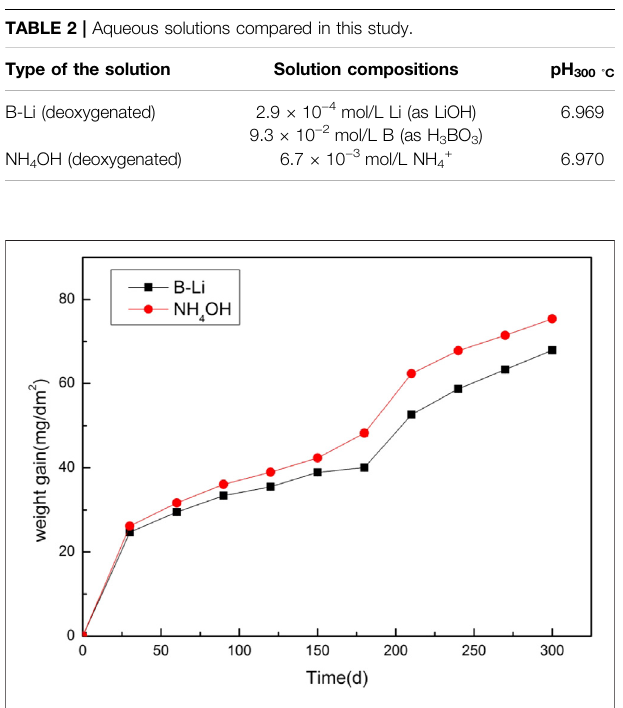
Frontiers in Materials |